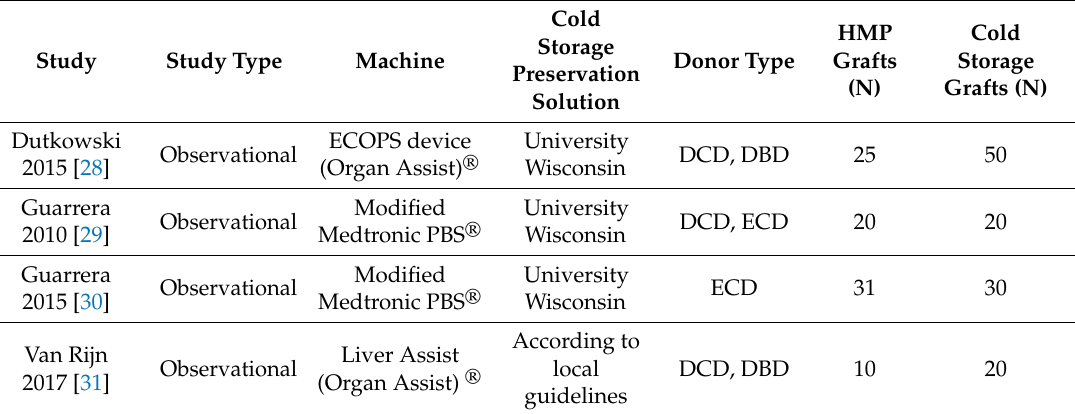
Table 3. Studies comparing HMP and SCS in liver.